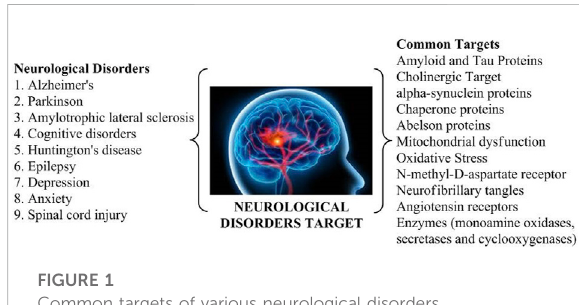
FIGURE 1 Common targets of various neurological